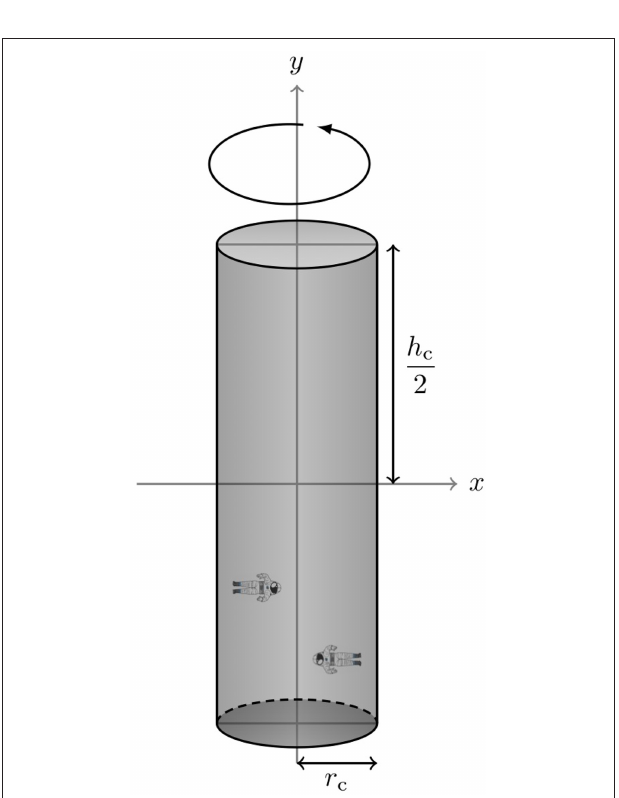
FIGURE 1 | Sketch of a cylindrical space station of height h c and radius r c